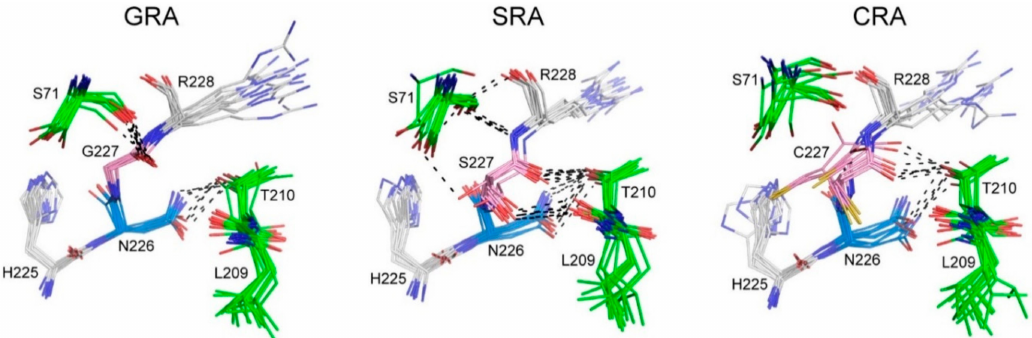
Figure 6. Conformational ensembles of the cleavage sites of CBD-INT-OCV-cecB2 fusion protein variants during 10 ns of MD simulation. For clarity, catalytic Asn (N226) and the + 1 position residues (G227, S227, or C227) of OCV are colored in light blue and pink, respectively. The neighboring residues are in green. The potential hydrogen bonds are depicted as black dashed lines.